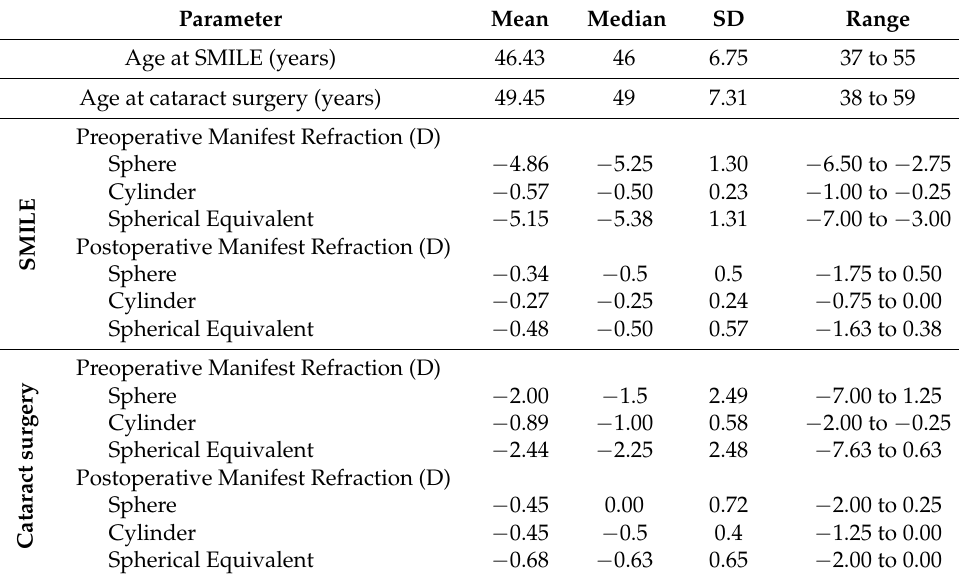
Table 2. Subjects’ characteristics.